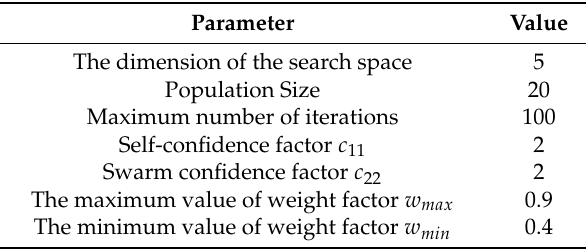
Table 1. The set values of the particle swarm optimization (PSO)